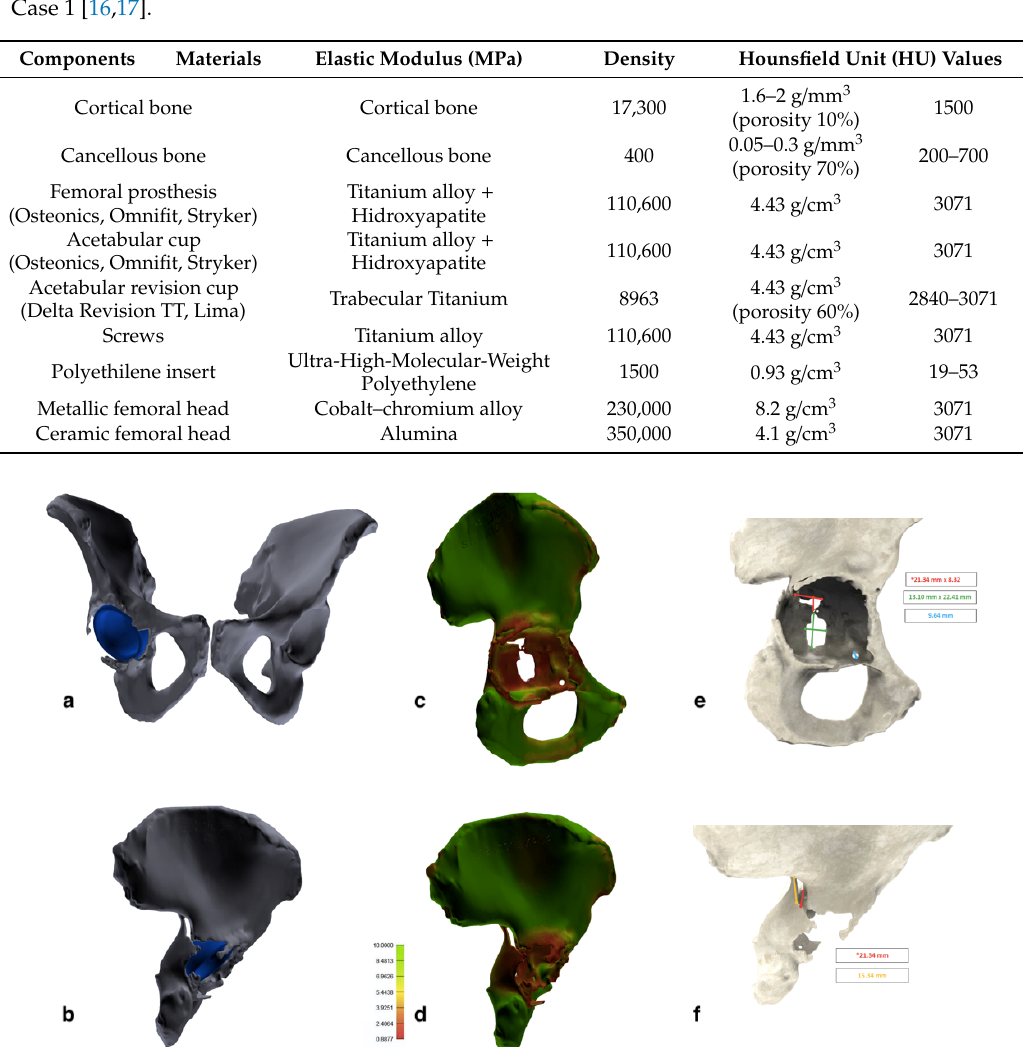
Figure 3. Tridimensional images elaborated with the 3D modeling software. ( a , b ) Entire pelvis with the acetabular cup retained. Femurs and femoral stem were removed during segmentation. ( c , d ) Bone quality map shows regions with normal bone quality (green) and regions with low bone quality and thickness (red). ( e , f ) Measurements of the bone defect area and fracture extension.